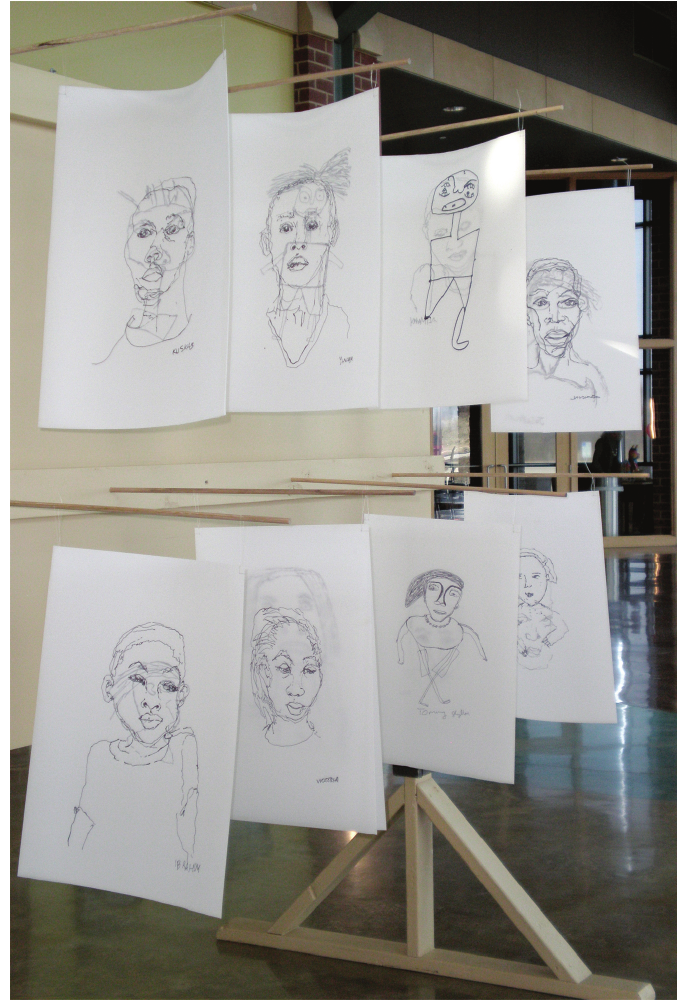
Figure 2. Interfacings Series. Artist